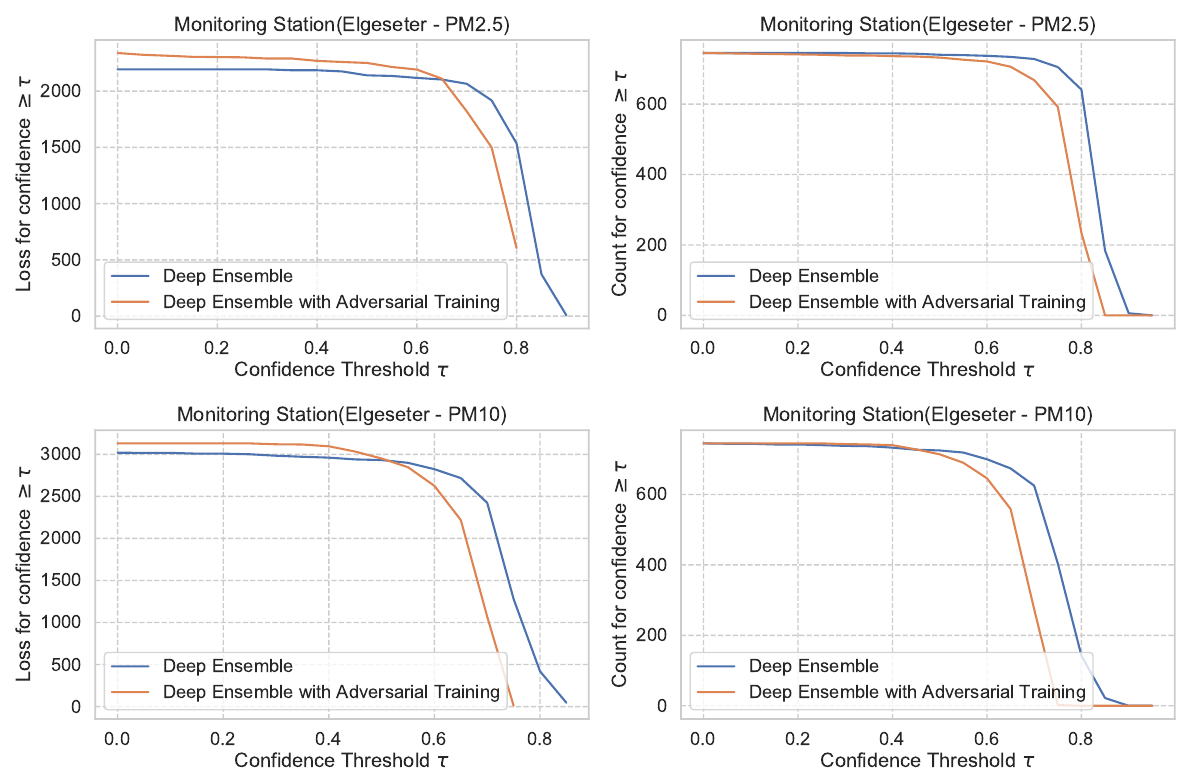
Figure 29. Impact of adversarial training on predictive uncertainty in PM-value regression, using deep ensemble as an example. ( Left: ) loss versus confidence. ( Right: ) count versus